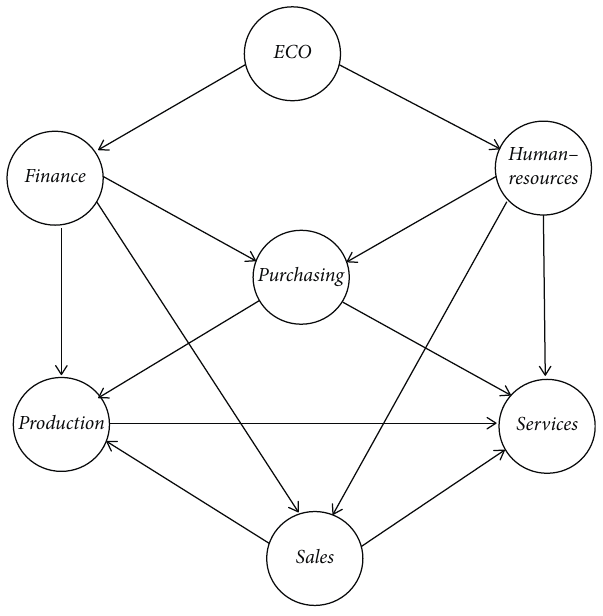
Figure 2: 2-polar IVIFG related to managers. Table 5: 2-polar IVIF of relationships between